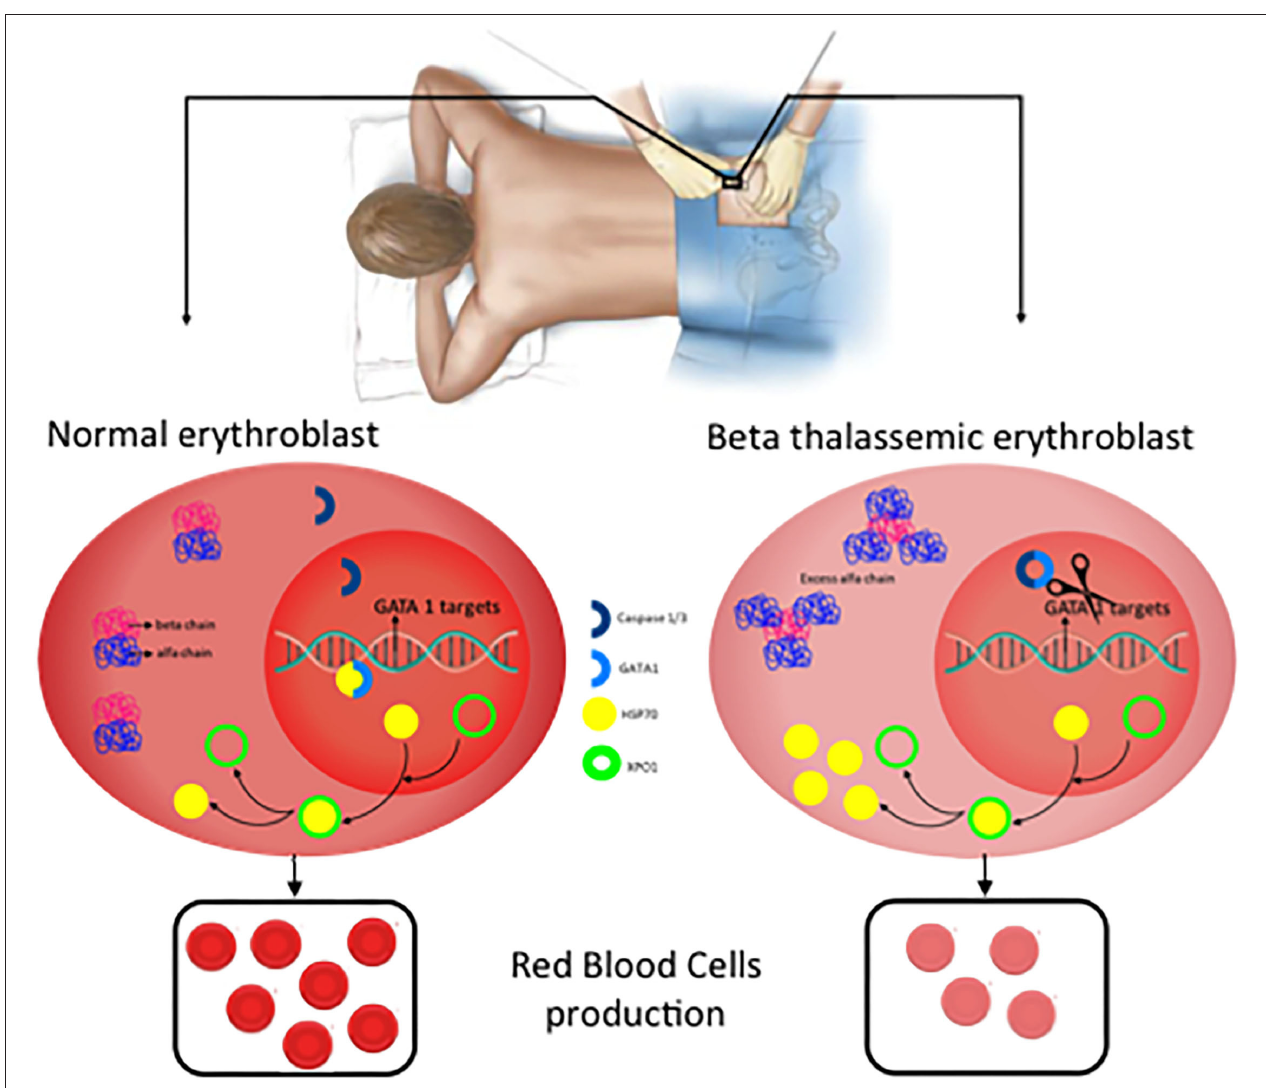
FIGURE 4 | New potential treatments for β -thalassemia. In normal erythroblast, GATA1 levels are regulated through the balance Caspase 3/1 cleavage and HSP70 protecting function in the nucleus. As a consequence, normal and functional erythrocytes are produced. In contrast, in β -thalassemic erythroblast, the lack of functional β -globin chains induces accumulation of free α -globin chains which restrict HSP70 distribution to the cytoplasm and therefore GATA1 is cleaved by Caspase 3/1 which result in fewer functional matured